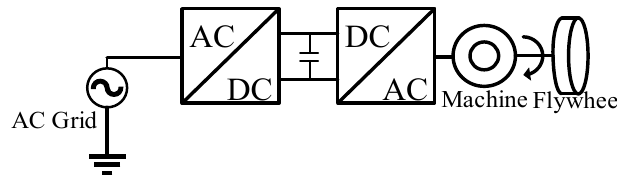
Figure 22. Direct AC converters with flywheel.